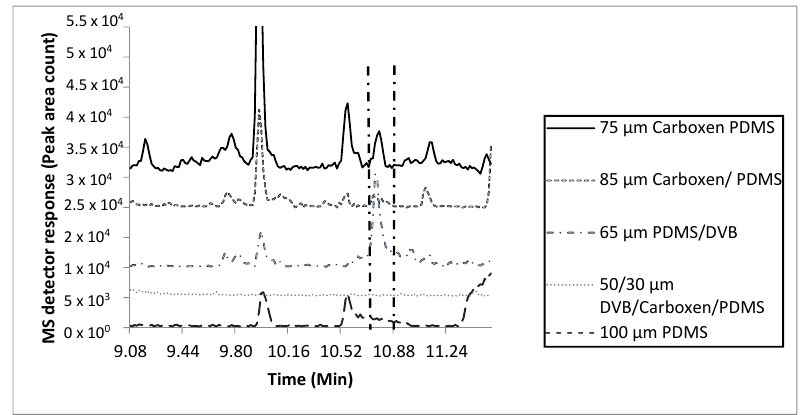
Figure 1. Effects of fiber coating type on SPME adsorption of 2-acetyl-1-pyrroline, the characteristic odorant compound released from marking fluid of P. tigris altaica with 85 µ m CAR/PDMS, 50/30 µ m DVB/CAR/PDMS, 100 µ m PDMS, 65 µ m PDMS/DVB, and 75 µ m CAR/PDMS SPME fibers.